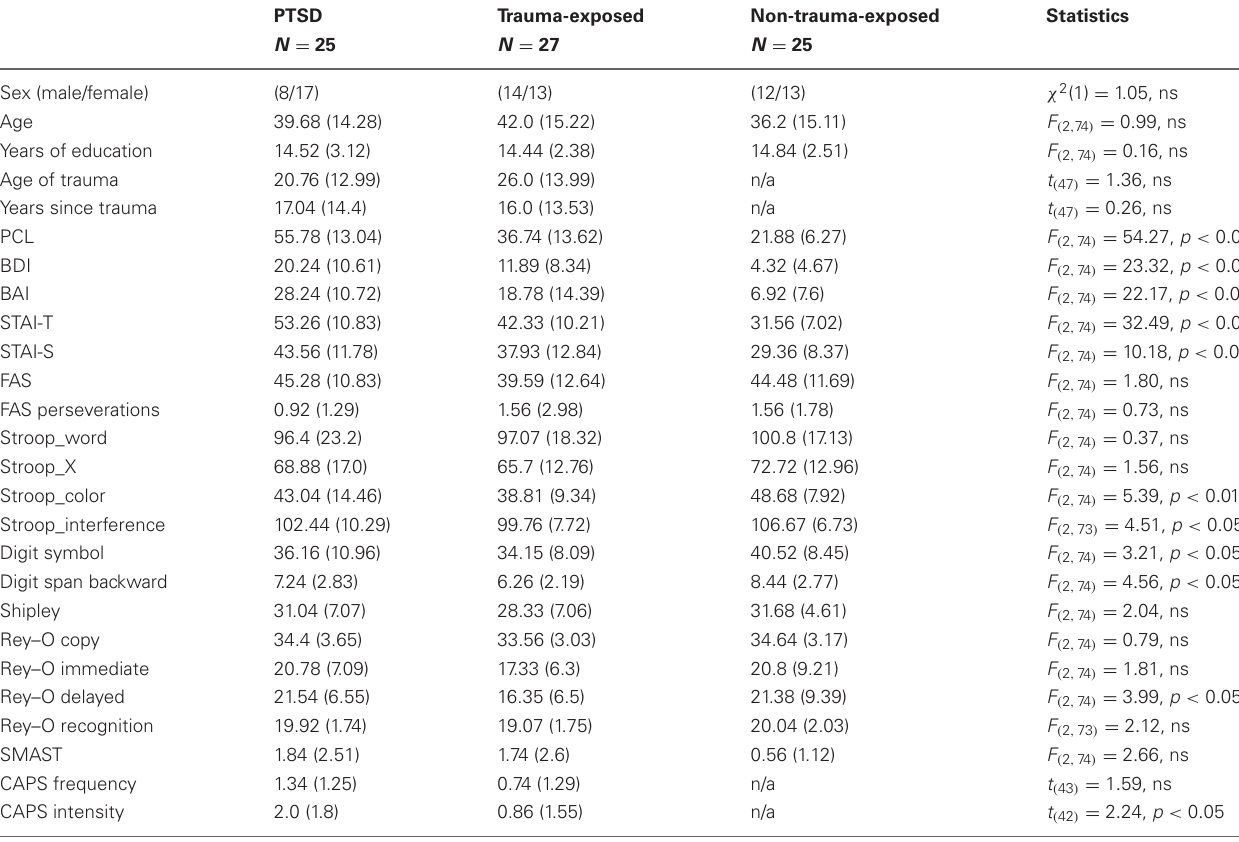
Table 2 | Demographic, cognitive, and psychopathological characteristics of the samples.